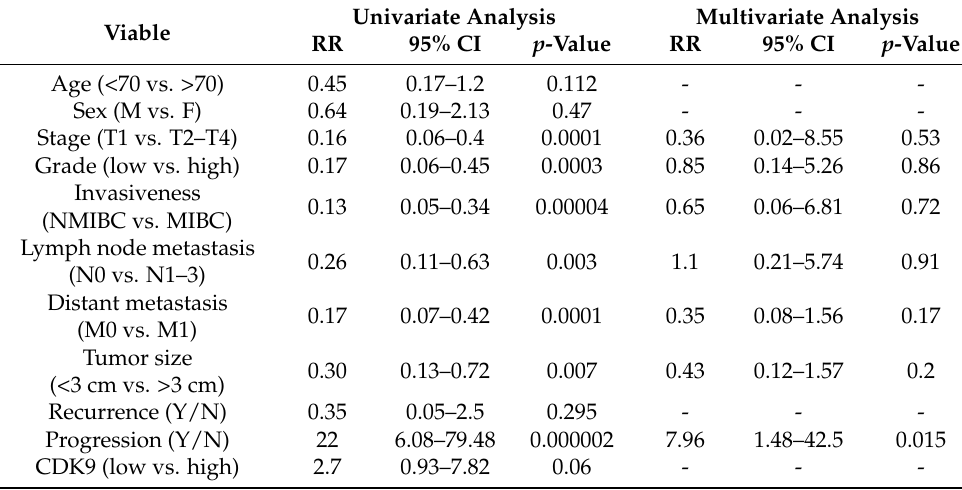
Table 3. Univariate and multivariate analysis of overall survival.